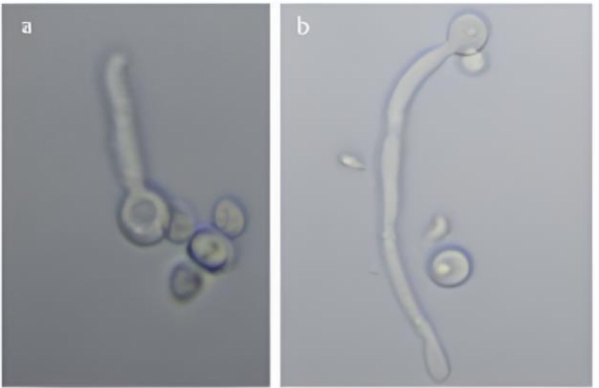
Figure 1. Formation of C. albicans Germ tube ( a , b ) in horse serum incubated for 3 h to form a germ tube at: 100 × magnification.